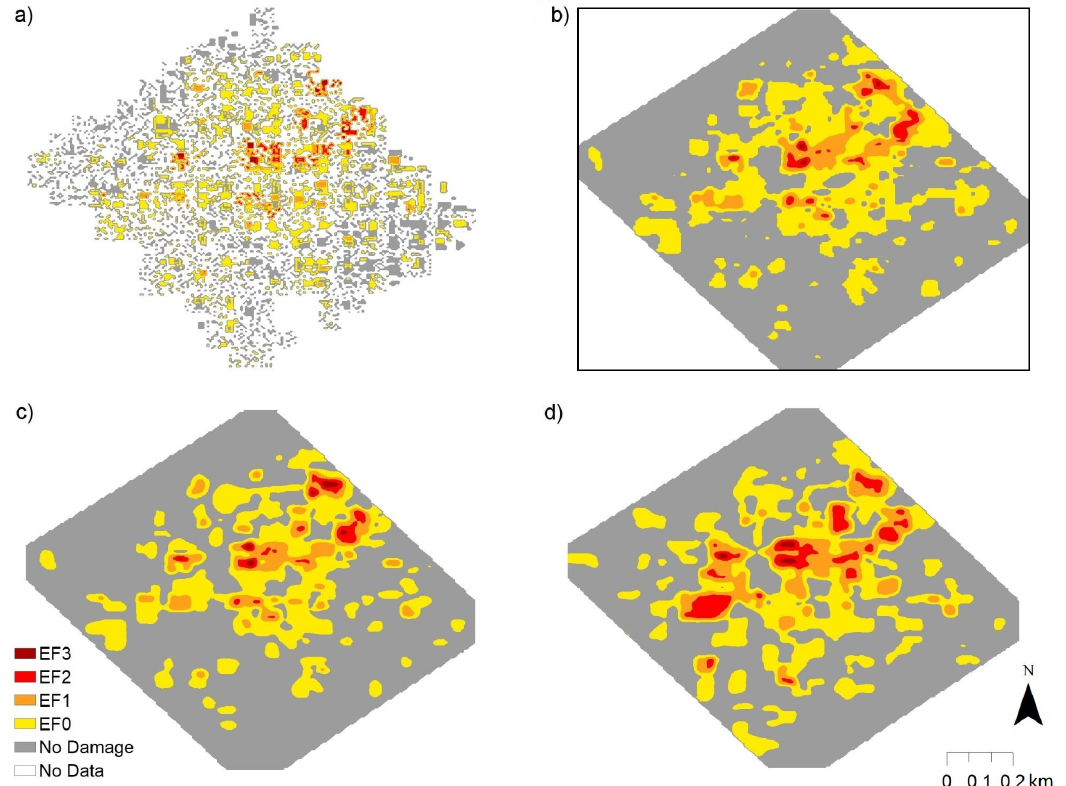
Figure 10. ( a ) One sample of GP regression training datasets from neural network inference, including all valid points from multi-class object detection and 30% randomly sampled valid data points from multi-class image classification. ( b ) Tornado damage heatmap from GP regression using the GP training dataset (Figure 10a). The pixel-wise average of the multiple GP regression results from ( c ) neural network inference and ( d ) ground-truth annotations. The border provided in Figure 10b is applicable to all other heatmaps; however, it was not displayed to maintain clean visualization. The white areas within the border indicate “No